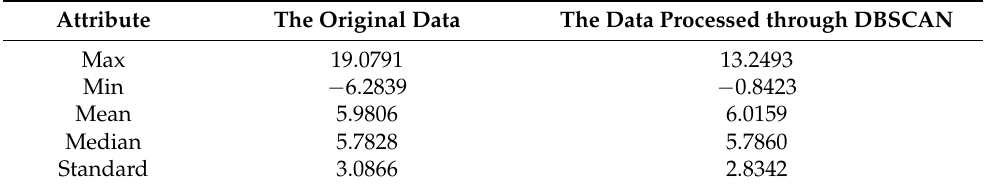
Table 2. Summary statistics of the original data and the data processed through